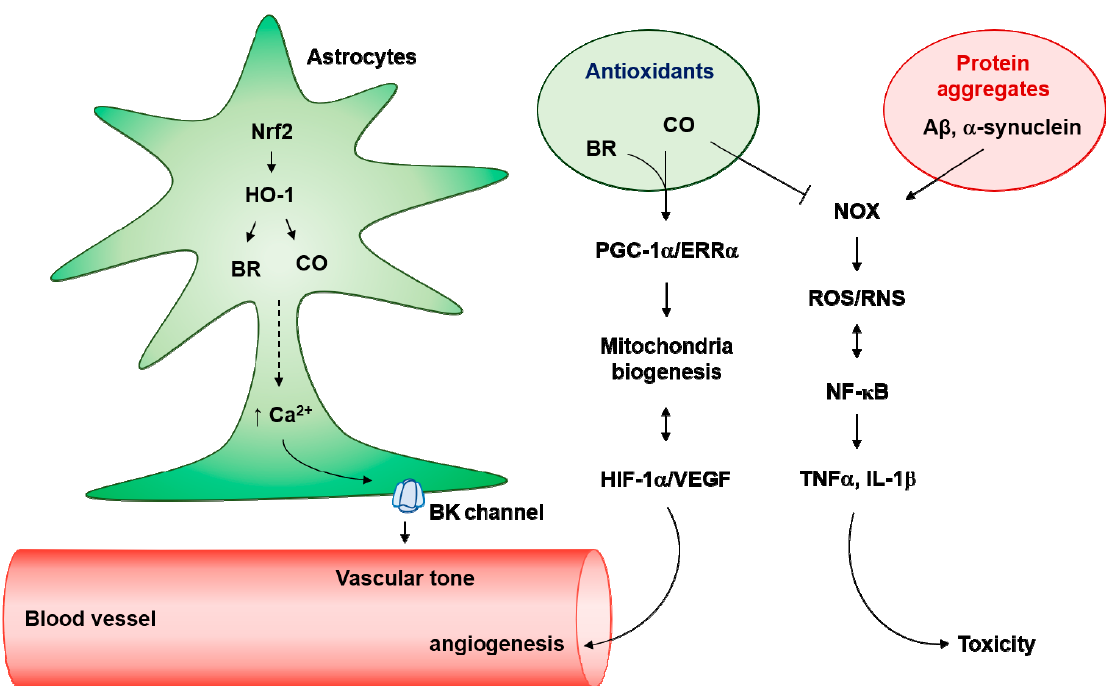
Figure 3. Antioxidant effects of astrocytes on neurotoxic protein aggregates. Nuclear factor erythroid 2-related factor 2 (Nrf2)/heme oxygenase (HO-1) pathway produces carbon monoxide (CO) and bilirubin (BR) in astrocytes, which induces Ca 2+ -enhanced K + channel activation. Astrocytes endfeet big conductance K + (BK) channels can regulate vascular tone. In addition, the Ca 2+ -mediated peroxisome proliferators-activated receptor γ -coactivator-1 α (PGC-1 α )/estrogen-related receptor α (ERR α ) axis can facilitate mitochondria biogenesis. Elevated O 2 consumption by mitochondria biogenesis results in hypoxia-inducible factor-1 α (HIF-1 α ) stability and vascular endothelial growth factor (VEGF)-mediated angiogenesis. Interestingly, activated HIF-1 α /VEGF may induce astrocytic mitochondrial biogenesis. In pathologic conditions, neurotoxic protein aggregates such as A β and α -synuclein can facilitate nicotinamide adenine dinucleotide phosphate oxidase (NADPH oxidase, NOX)-mediated reactive oxygen species (ROS) production and kappa-light-chain-enhancer of activated B cells (NF- κ B) activation. NF- κ B-mediated inducible nitric oxide synthase (iNOS) activation results in the production of and reactive nitrogen species (RNS). Crosstalk between ROS/RNS and NF- κ B stimulates the secretion of neurotoxic cytokines such as tumor necrosis factor α (TNF α ) and interleukin (IL)-1 β . Antioxidants (i.e., CO and BR) may block the NOX-mediated ROS/RNS generation in astrocytes.